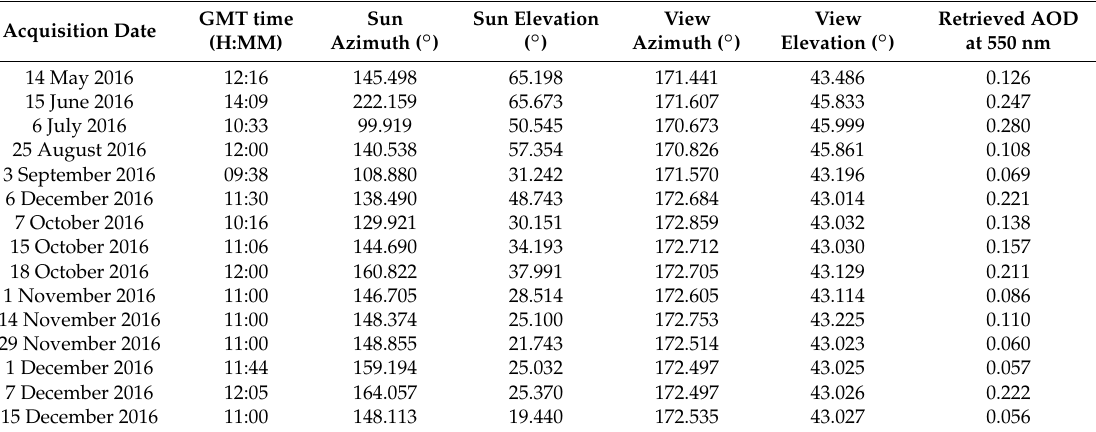
Table 7. Acquisition times, angles’ information, and retrieved Aerosol Optical Depths (AODs) of the selected GF-4/PMS images.